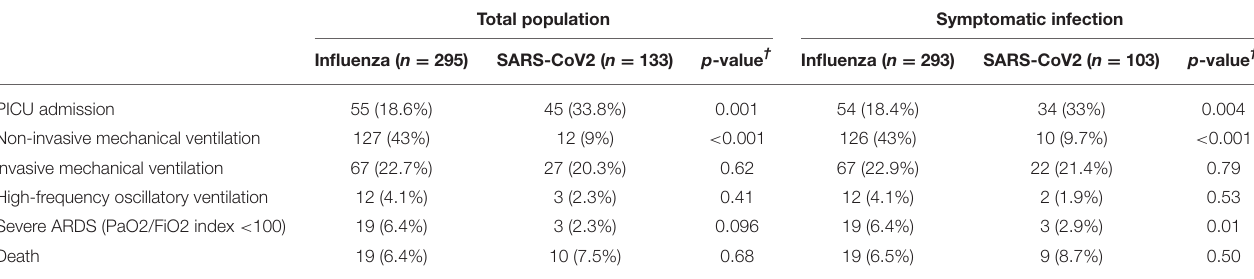
TABLE 3 | Main outcomes of patients with influenza and SARS-CoV2 infection.